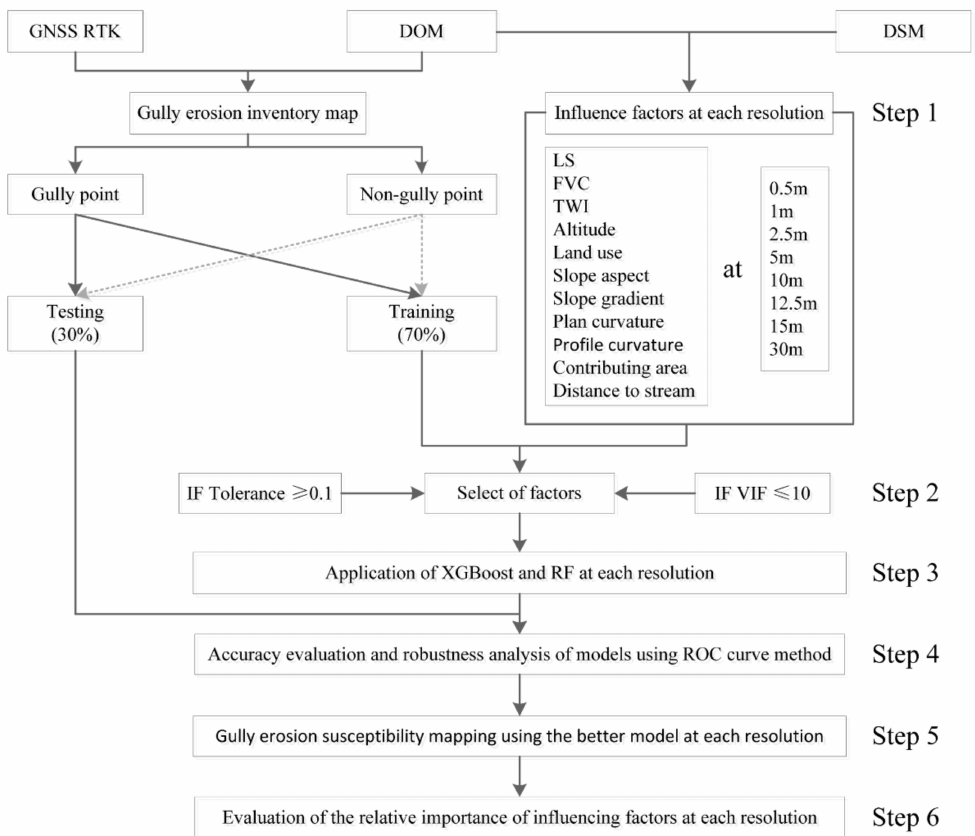
Figure 2. Study flow